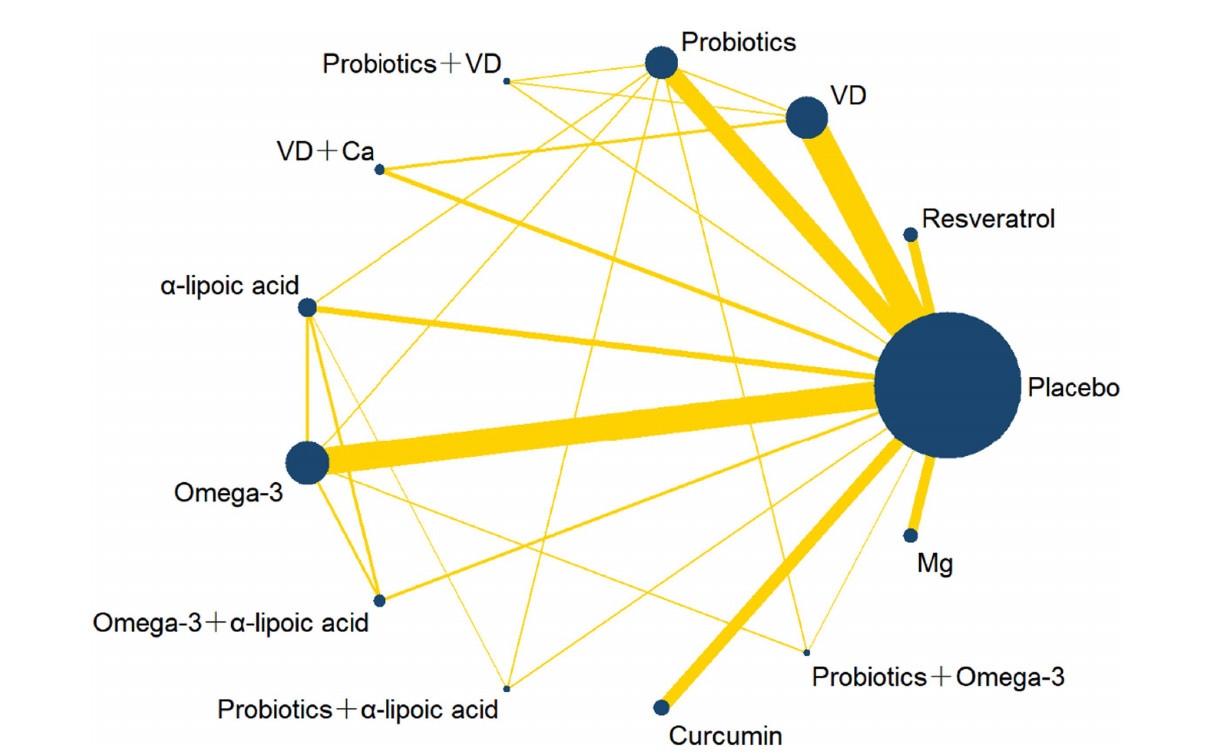
FIGURE 2 Network plot of different nutrition supplements for overweight and obese treatment. The width of the line is directly proportional to the number of treatments for each pair; the area of the circle represents the cumulative number of patients per intervention. VD, Vitamin D; Ca, Calcium; Mg,